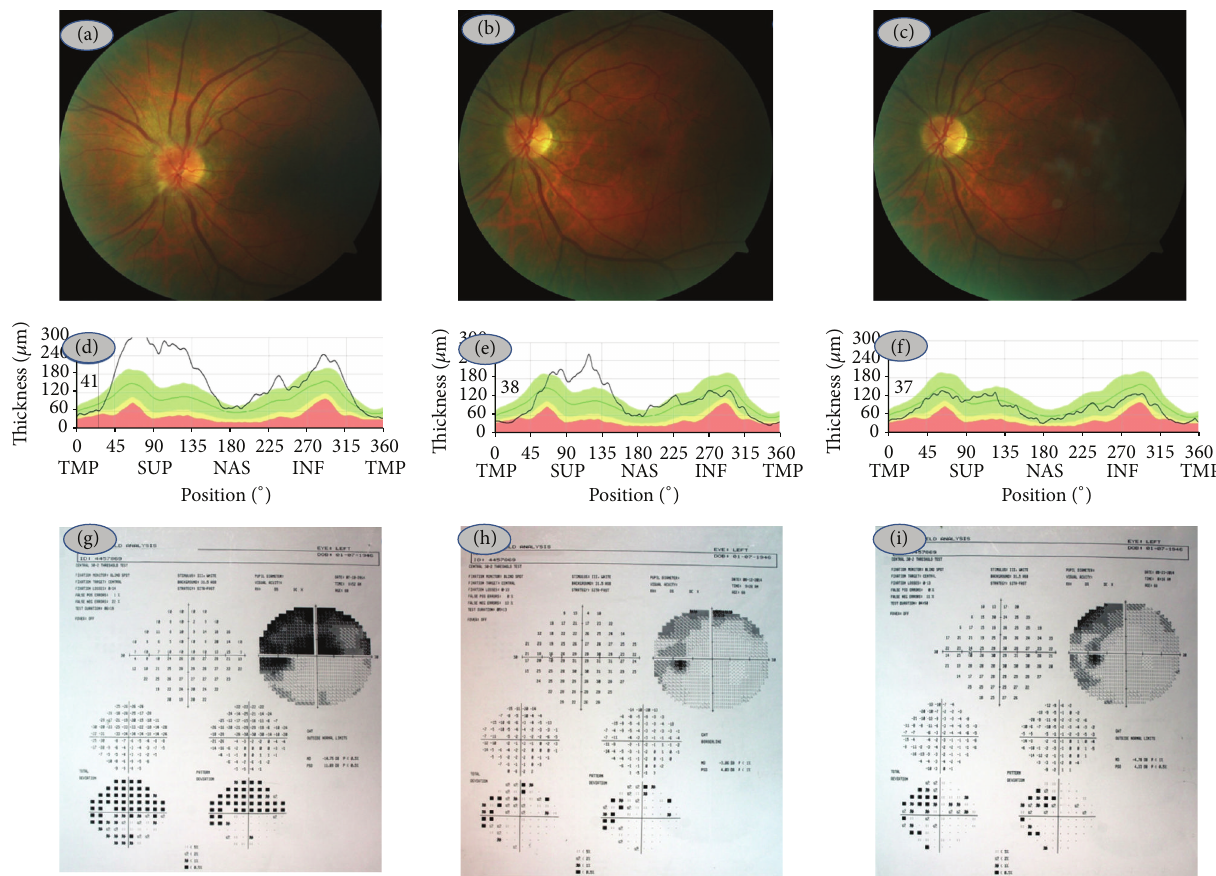
Figure 2: Left eye, colour fundus picture at the first week (a), first month (b), and third month (c), retinal nerve fiber layer thickness at the first week (d), first month (e), and third month (f), and visual fields at the first week (g), first month (h), and third month (i).